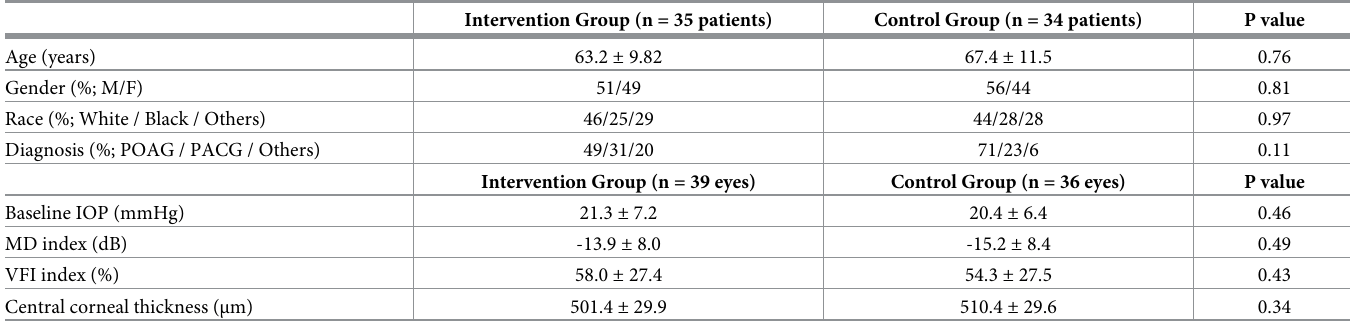
Table 1. Baseline demographic and ocular data of study